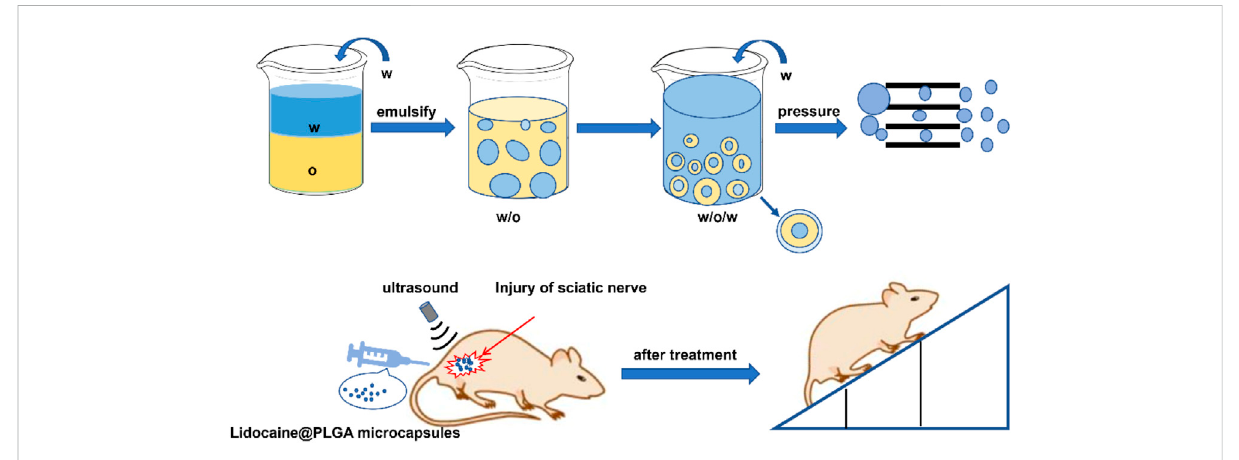
FIGURE 1 SchematicdiagramofthepreparationofLidocaine@PLGAmicrocapsules via thePMEmethodandtheirapplicationintheratsciaticnerveinjury